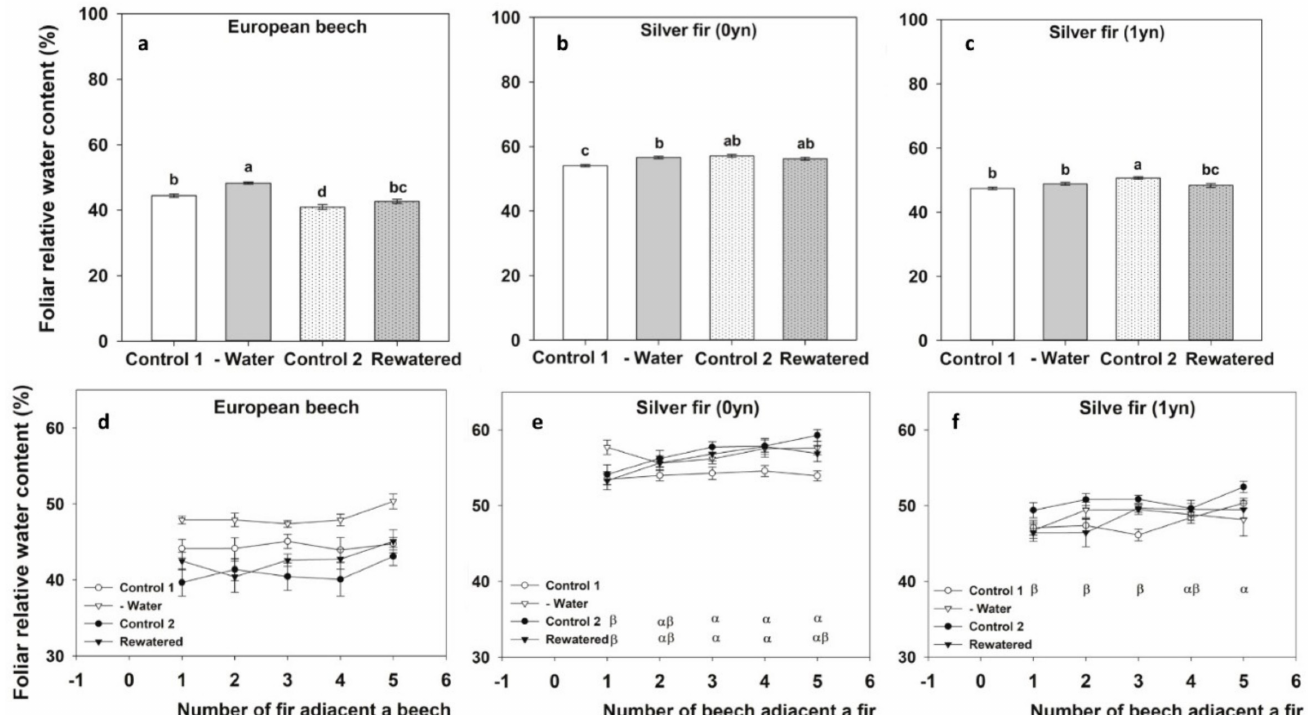
Figure 2. Foliar relative water content (RWC) of beech ( F. sylvatica L.) and silver fir ( A. alba Mill.) seedlings upon water deprivation ( − water) and rewatering. Leaves/needles of control 1 were collected on the 27 to 28 July, leaves/needles of control 2 on the 8 to 9 August. 0yn, current − year needles; 1yn, one − year old needles. Significant differences between controls and treatments are indicated by different letters ( p ≤ 0.05; n = 80, ( a − c )), effect of the number of neighbouring trees (( d − f ), n = 5 − 30). Values shown are means ±